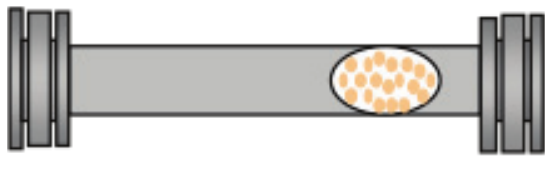
Figure 2 : Standard chromatography column filled with particles